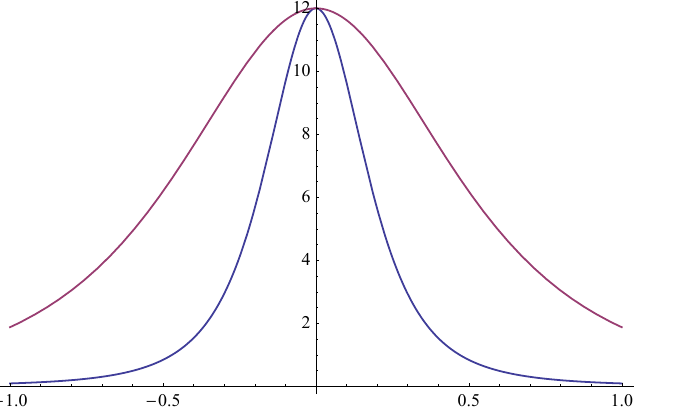
on the vertical varies from 0 at infinity to 2